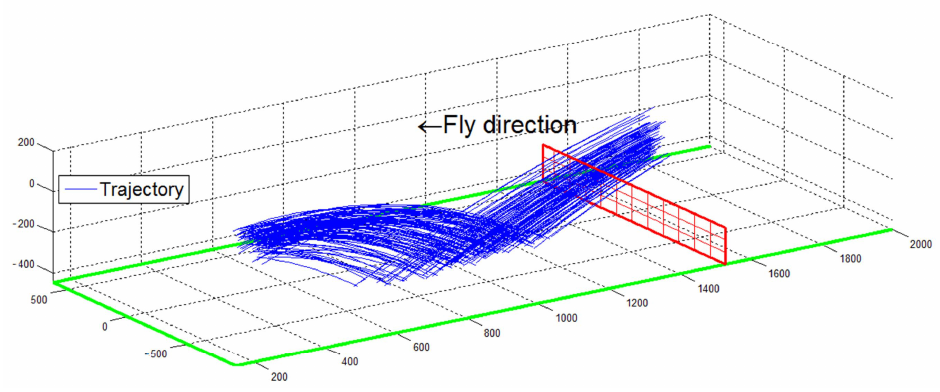
Figure 15. Flight trajectory data collected from human